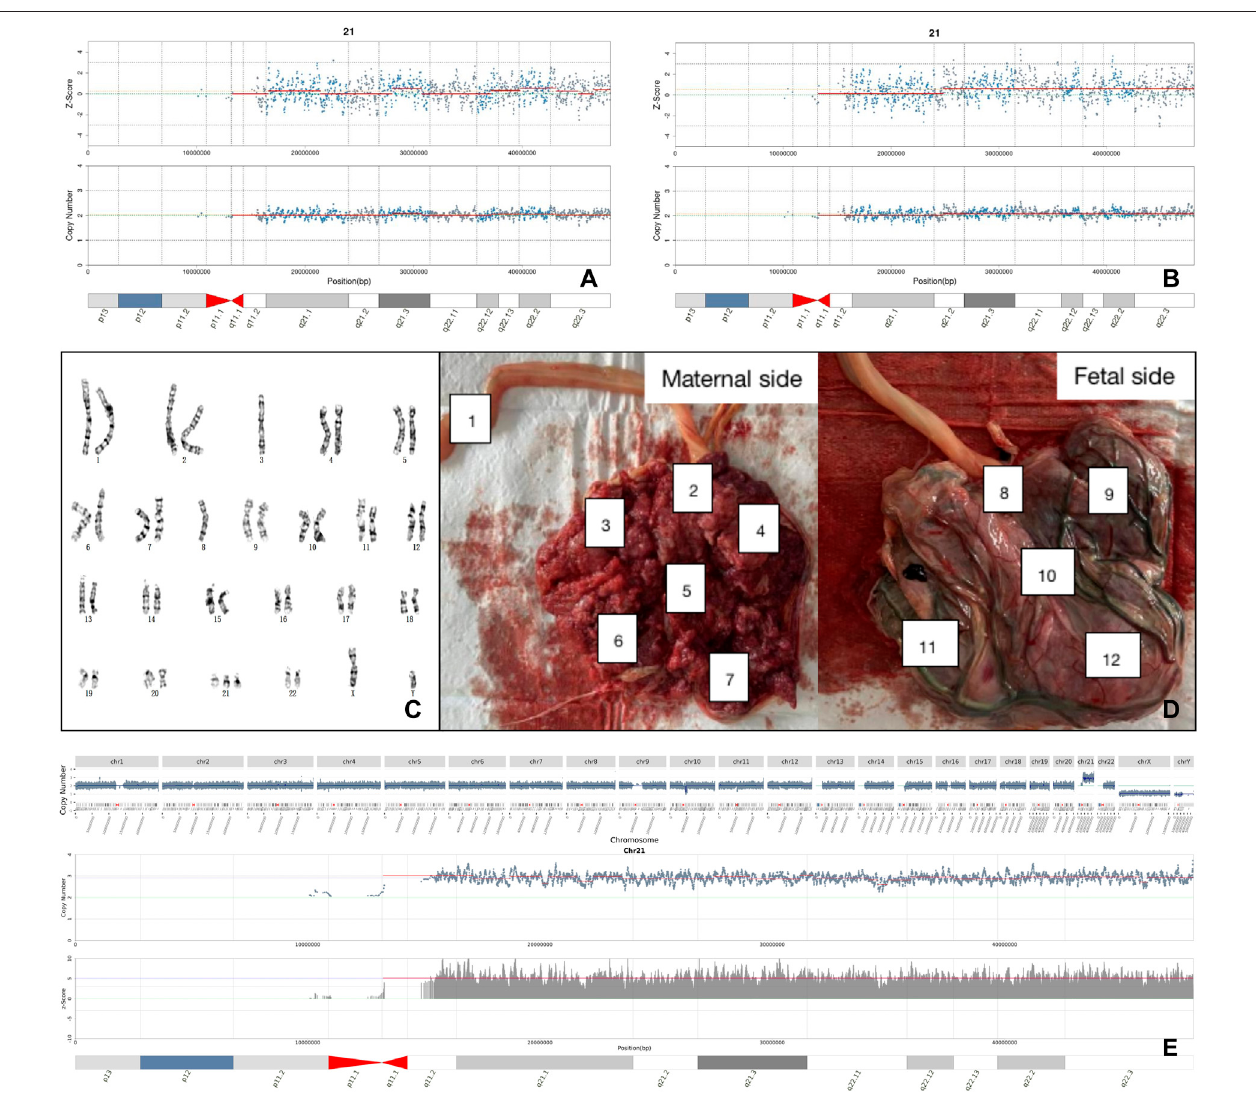
FIGURE 2 | Analysis of a false negative case. (A) The negative result of NIPT with fi rst blood sampling. (B) The positive result of NIPT with re-sampling. (C) The karyotype of fetal amniotic fl uid cell. (D) Sampling locations of placental tissue after labor induction. (E) Placental CNV-seq results suggested full T21.